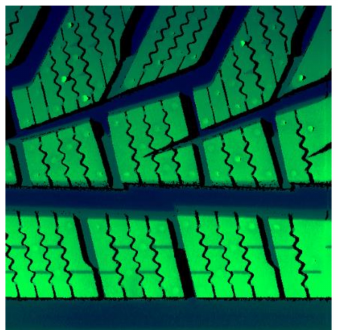
Figure 9. Stacked